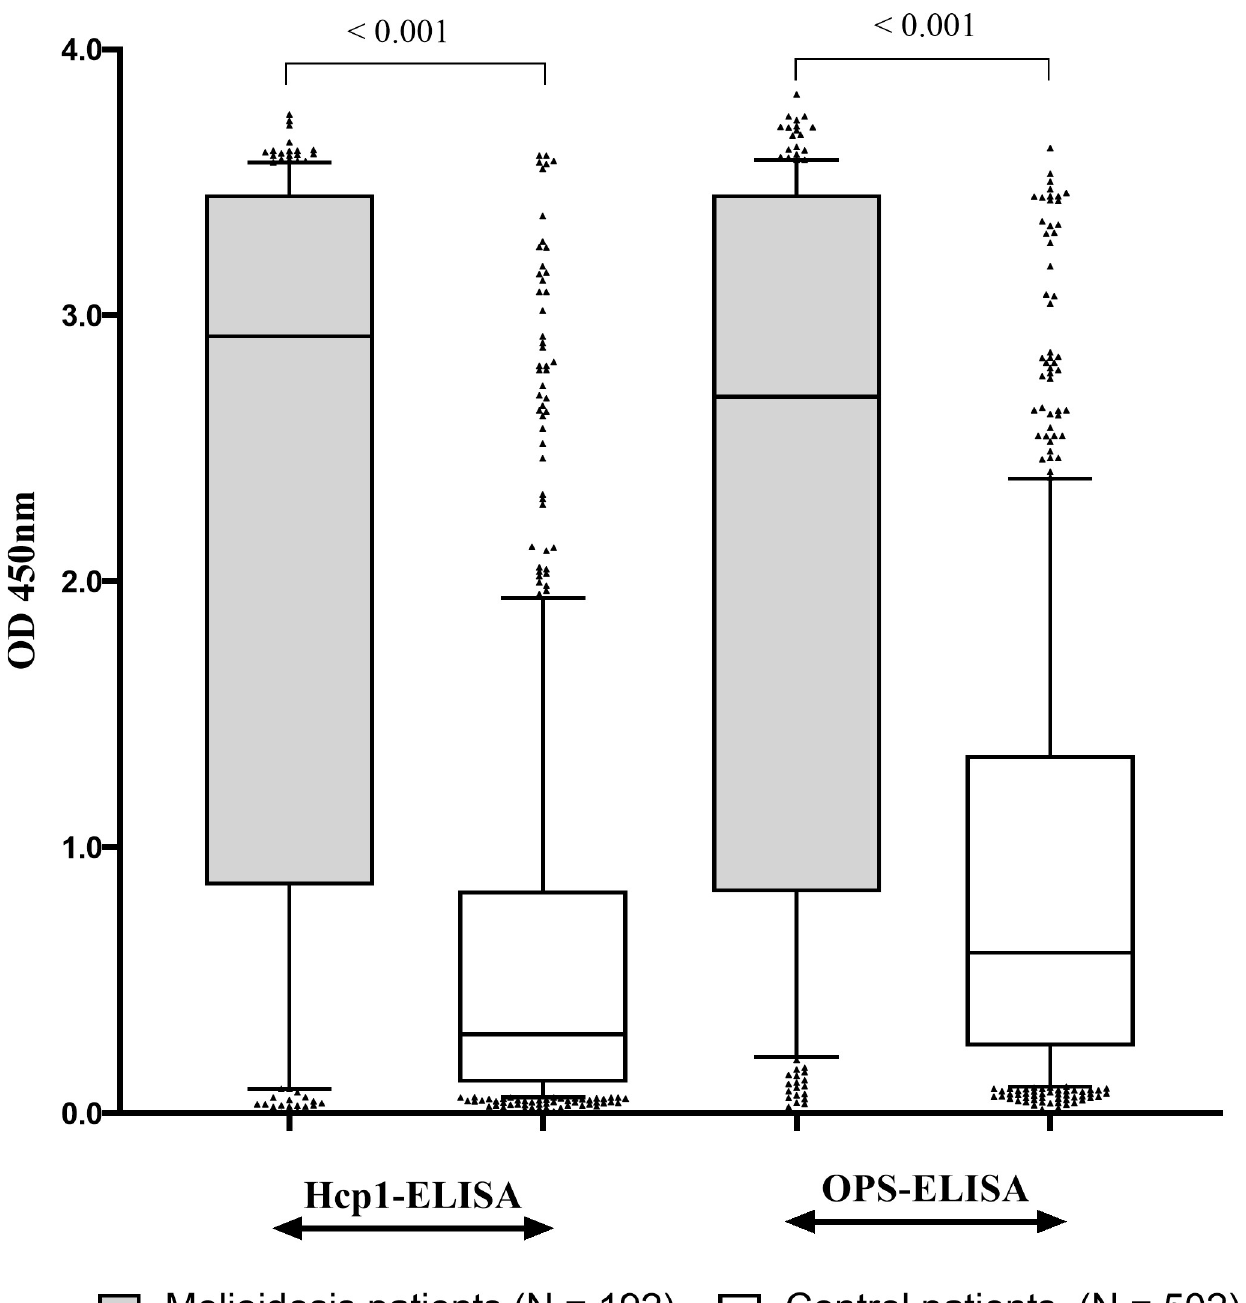
Fig 1. Results of Hcp1-ELISA and OPS-ELISA from culture-confirmed melioidosis cases and controls � . � Controls were patients whose blood culture were positive for Staphylococcus aureus , Escherichia coli or Klebsiella pneumoniae or those who were malaria or dengue polymerase chain reaction assay positive. Box plots represent 25 th and 75 th percentile boundaries in the box with the median line within box; the whiskers indicate the 10 th and 90 th percentiles. The plots show optimal density (OD) 450 of each antigen from serum samples collected within 24 hours of hospital admission from culture- confirmed melioidosis cases and